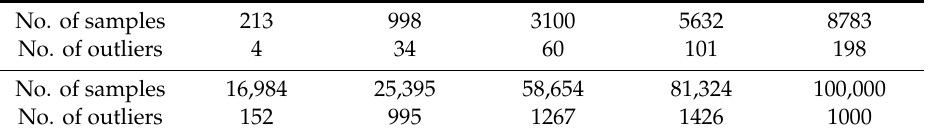
Table 1. The summary of 10 datasets ( | N | =